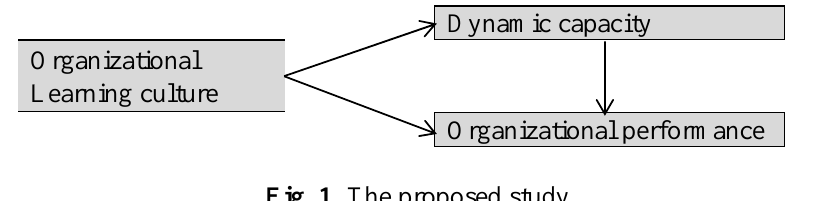
Fig. 1. The proposed